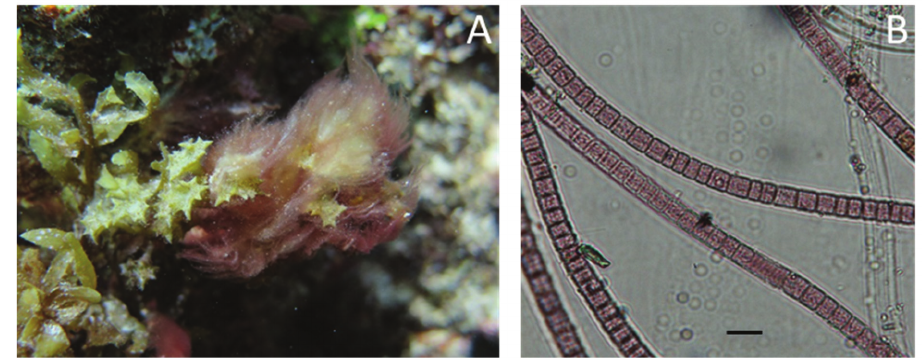
Figure 7. Leibleinia gracilis illustrations. ( A ) Tufts of L. gracilis overgrowing on the brown algae Turbinaria ornata . ( B ) Light microscopic images showing cell arrangements with fine constrictions at the cross-walls.